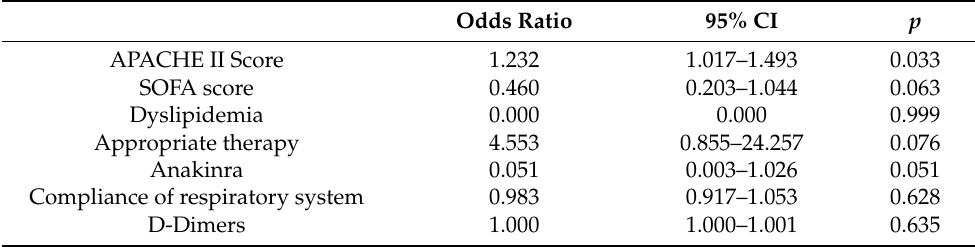
Table 7. Multivariate